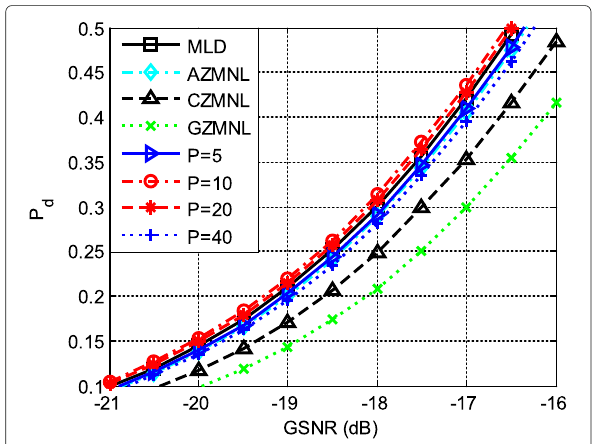
Fig. 6 Detection probability versus the GSNR in real atmospheric